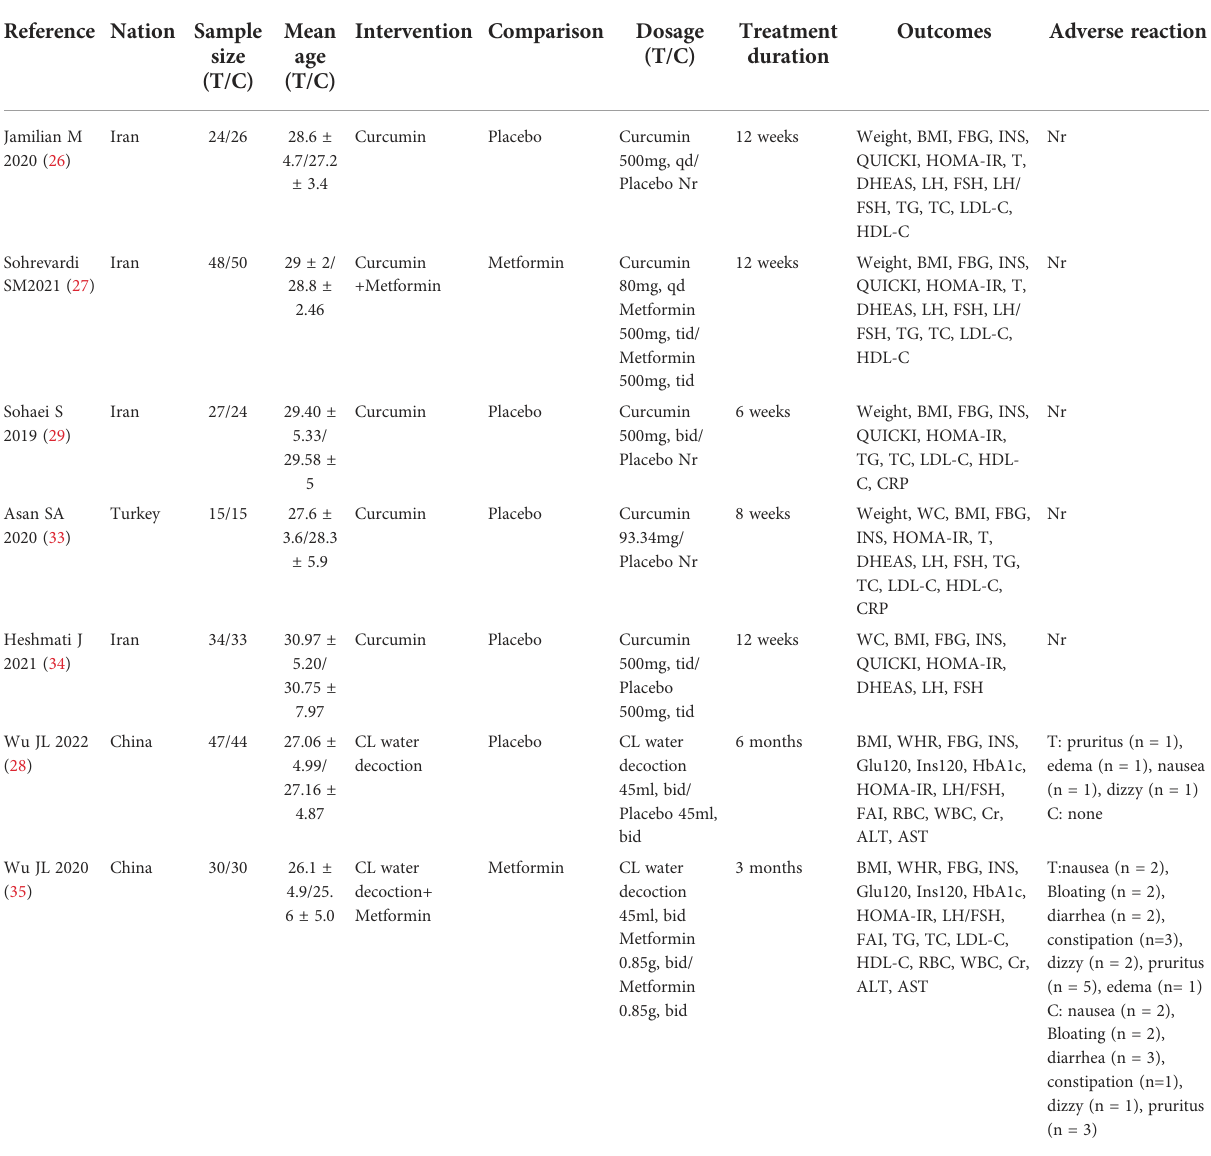
TABLE 1 The characteristics of the included studies.